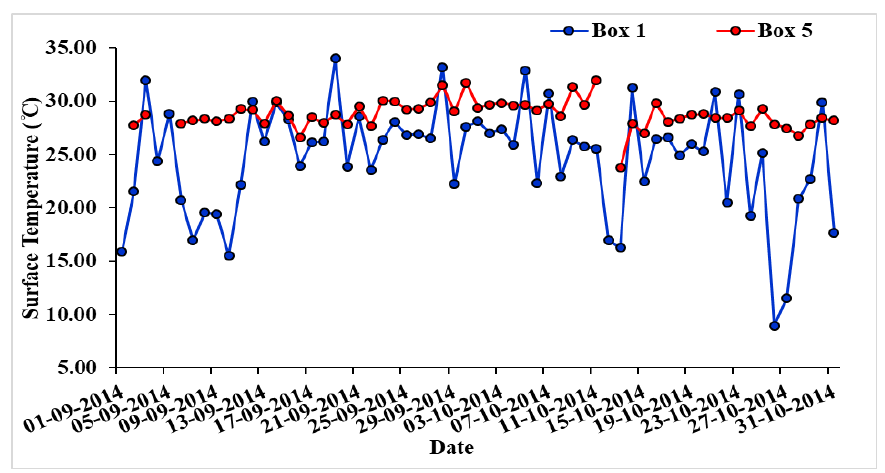
Figure 3. Temporal variation of surface temperature over land (Box 1) and the ocean (Box 5) during 1 September–31 October 2014.